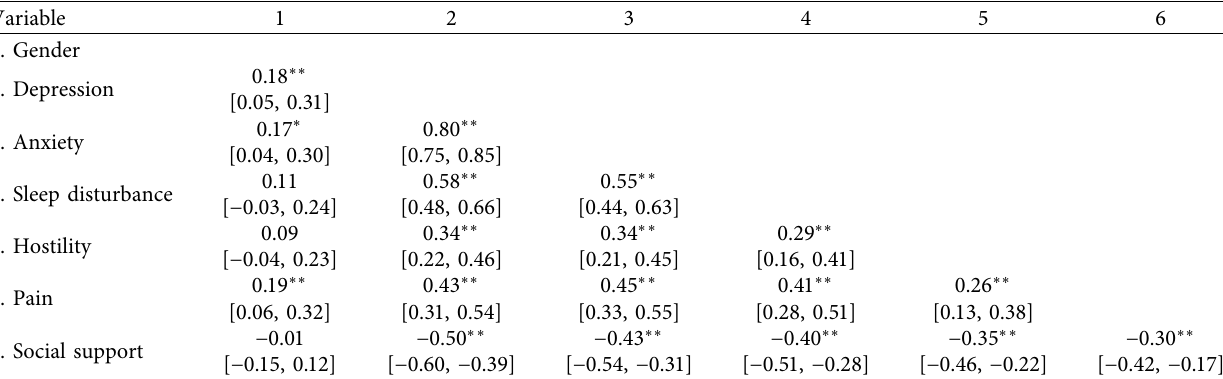
Table 3: Correlations with confidence intervals.